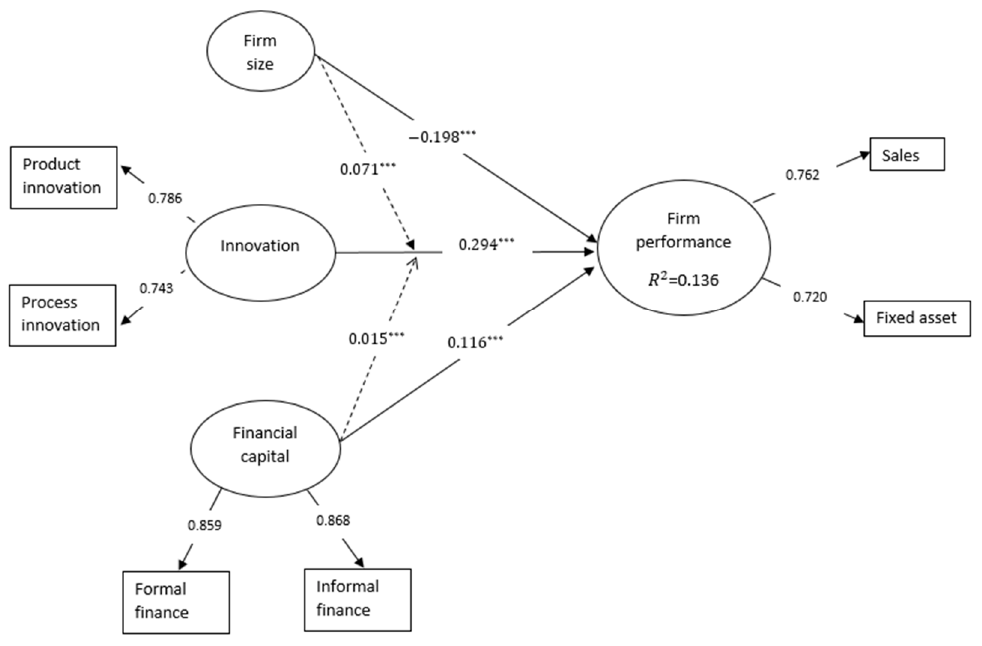
Figure 2. Structural model.